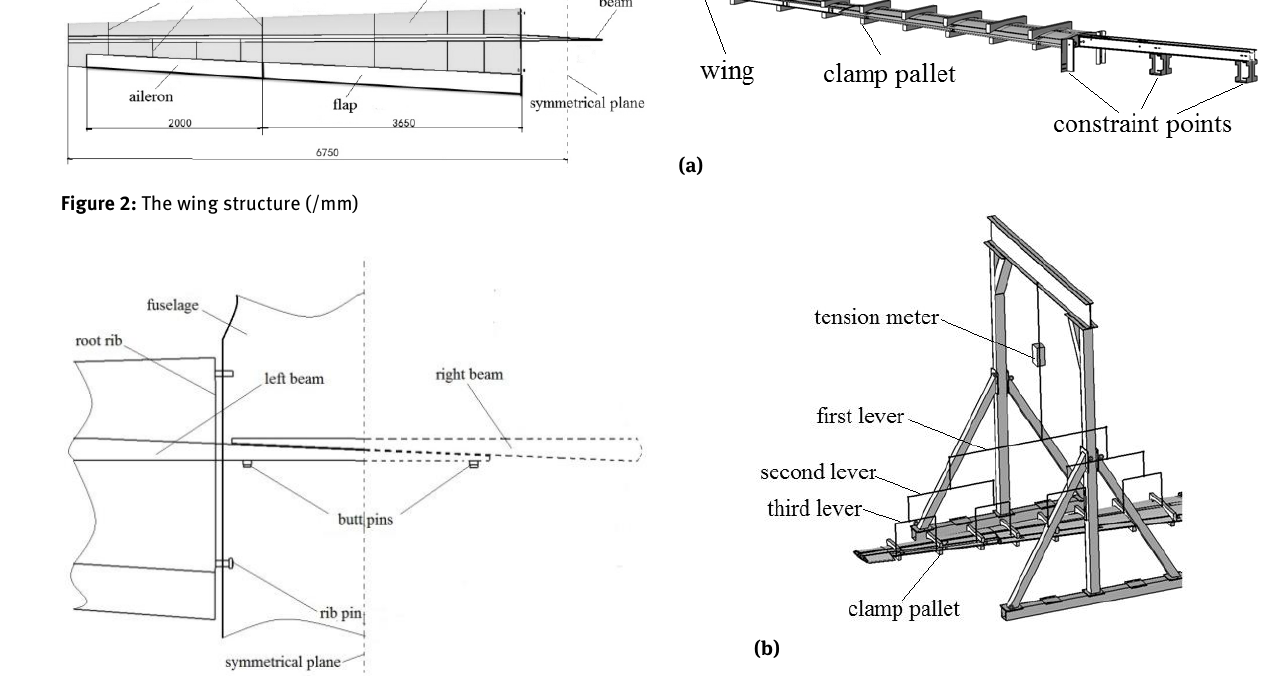
Figure 4: The loading system of wing pins, as shown in Figure 4(a). The loading equipment was electric portal jib crane, and tension was monitored by ten- sion meter, as shown in Figure 4(b). The wing was divided into 8 regions from the wing root to the wing tip, and the boundary of each region was be- tween the two adjacent pallets. According to the